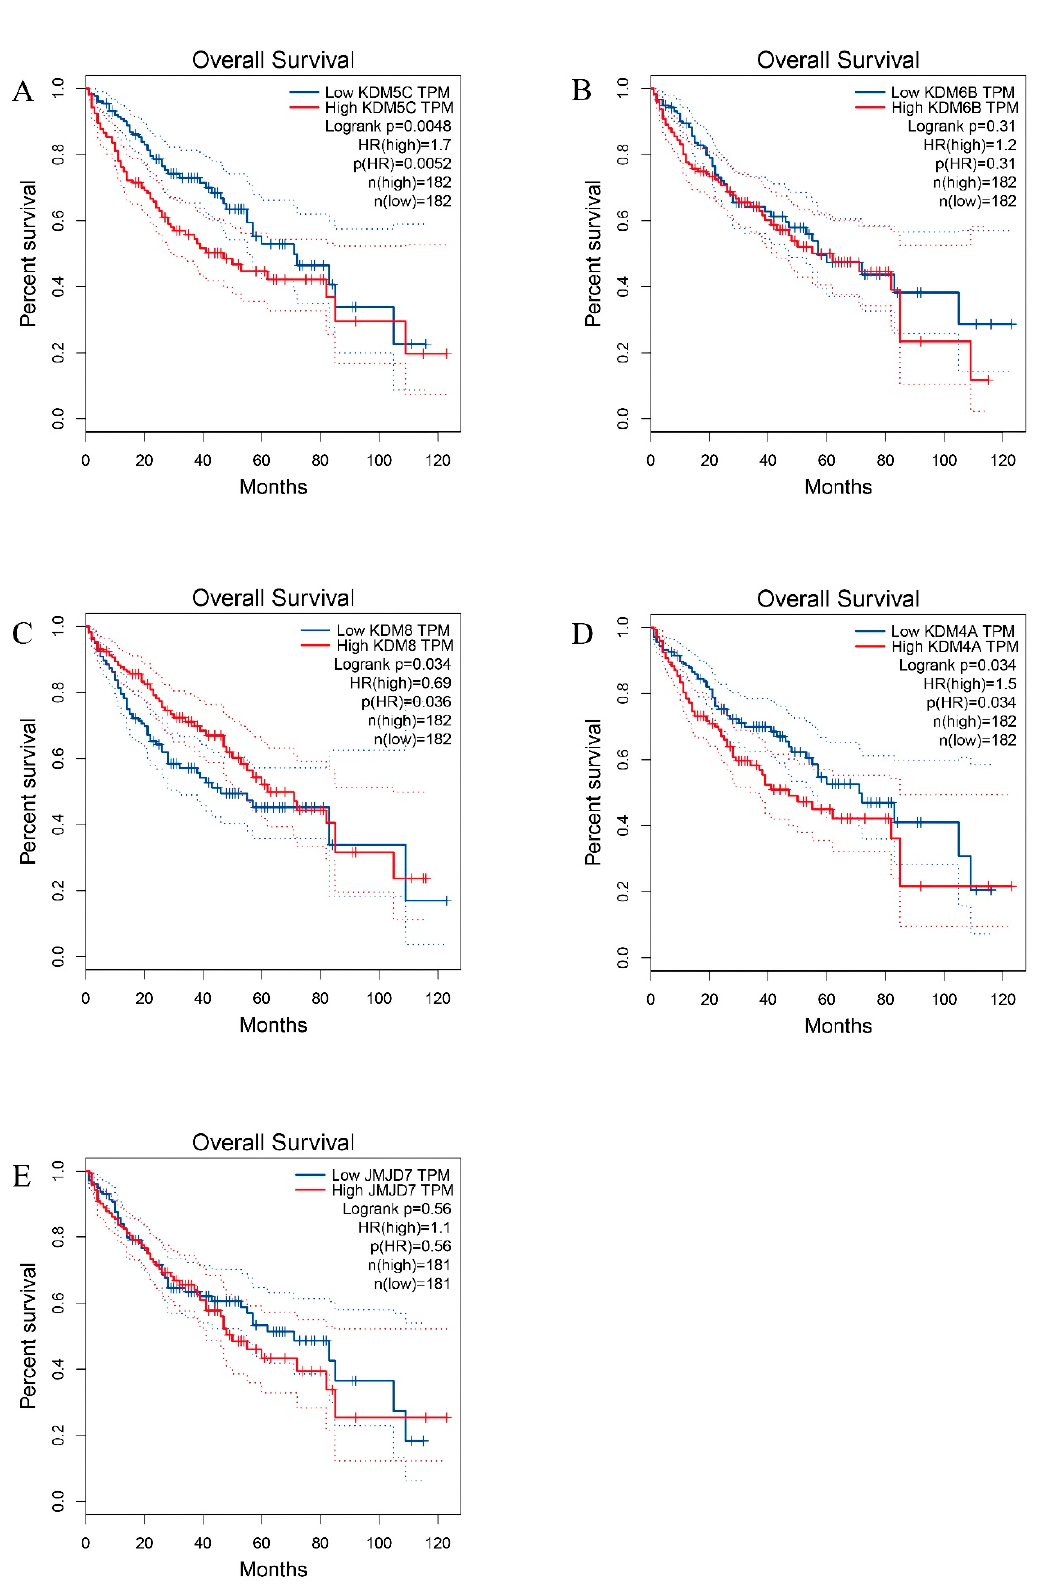
Figure 6. Prognostic values of five HDM genes for overall survival in HCC. ( A ) KDM5C. ( B ) KDM6B. ( C ) KDM8. ( D ) KDM4A. ( E ) JMJD7. Abbreviations: HCC, hepatocellular carcinoma; TPM, Transcripts Per Million; HR, hazard ratio.